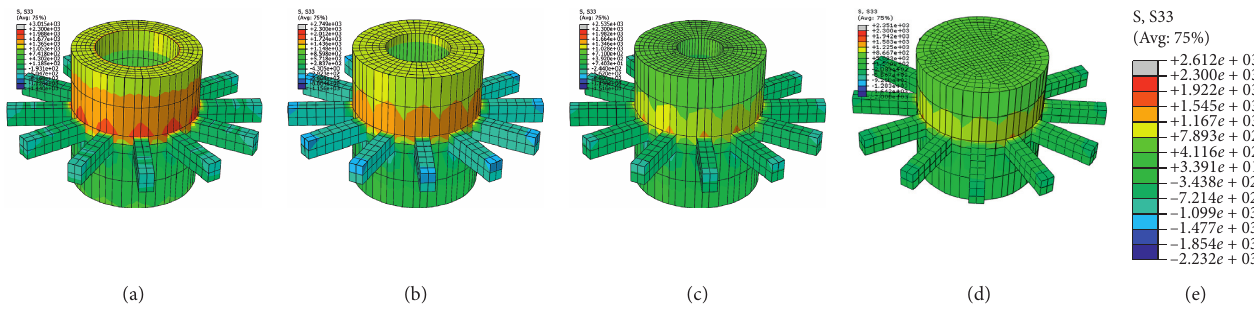
Figure 18: Axial stress distribution of piles of 2.8m in diameter with different wall thickness. (a) 0.5m. (b) 0.7 m. (c) 0.9 m. (d) Solid pile. (e) The legend.